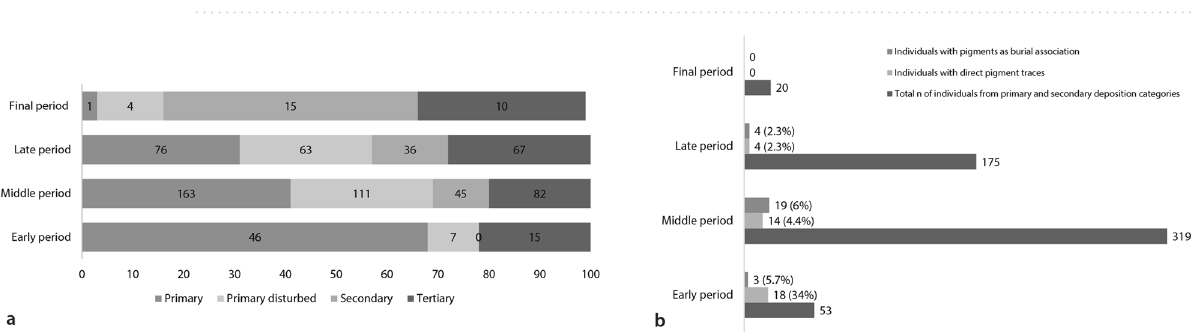
Figure 3. Distribution of Çatalhöyük human remains with pigments as burial association by ( a ) deposition category, ( b ) sex and ( c ) age-at-death. Charts generated with Microsoft Office Excel 2016 (https:// www. micro soft. com/ en- us/ micro soft- 365/ excel).